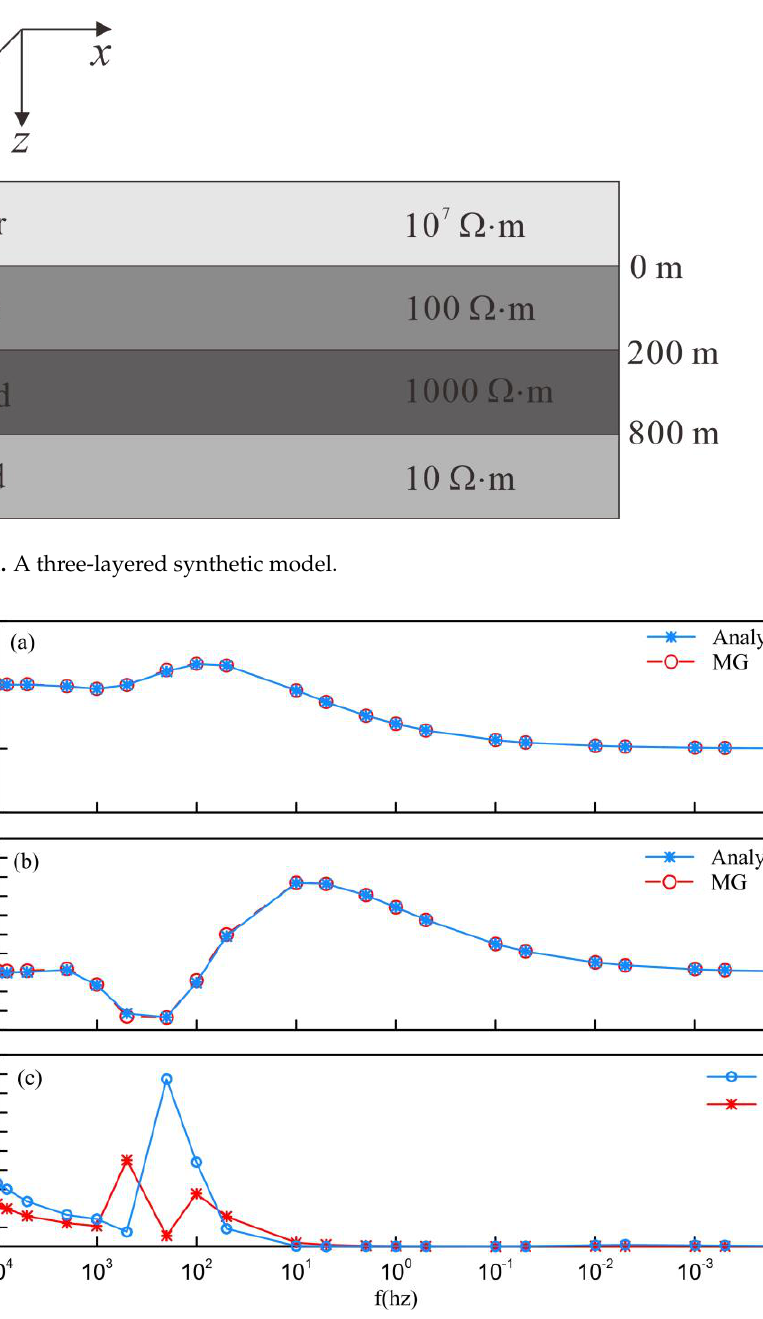
Figure 5. Comparison of our MG results with the analytic solutions for the layered model in Figure 4. ( a ) Apparent resistivity; ( b ) phase; ( c ) relative errors.